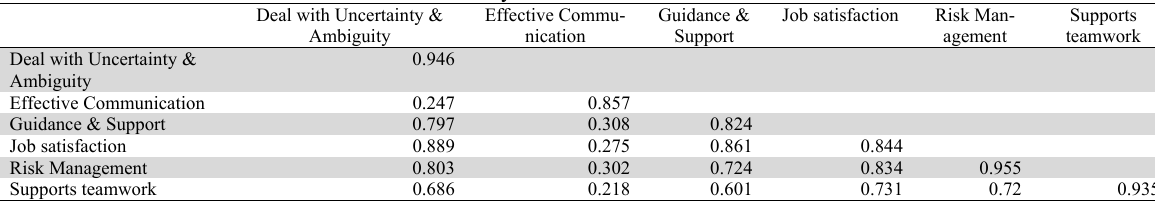
Supports agement teamwork